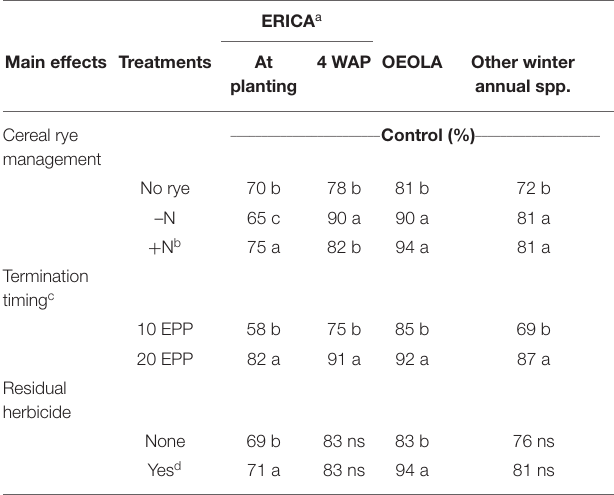
TABLE 3 | Influence of cereal rye management, termination timing, and residual herbicide on horseweed in 2016, cutleaf eveninggprimrose in 2017, winter annual weed control in 2016 and 2017 when rated at soybean